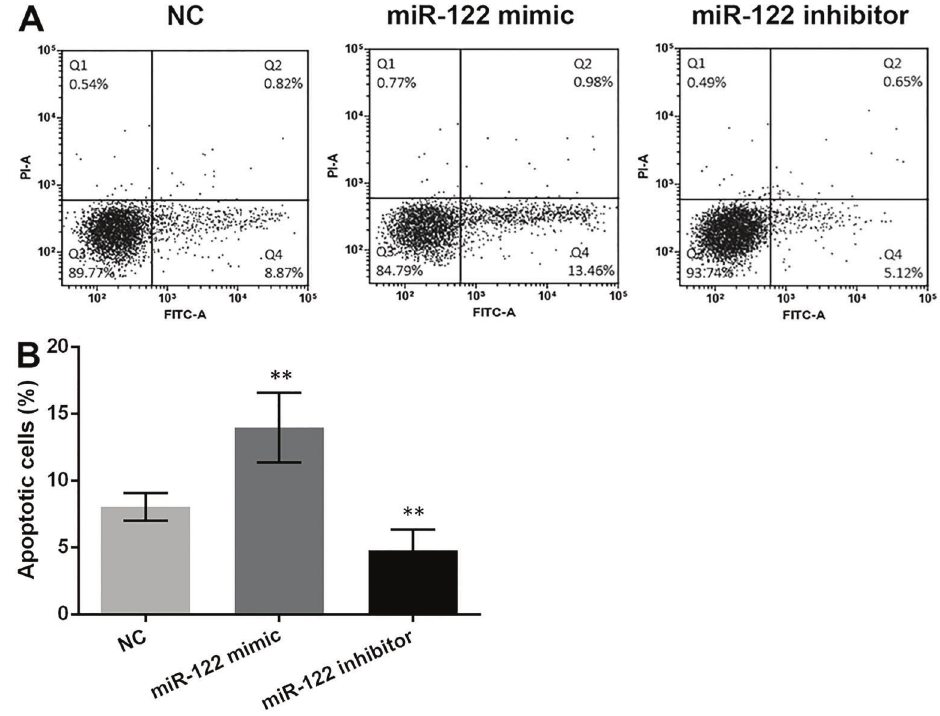
Figure 3. Apoptosis of transfected mouse cardiomyocytes. Mouse cardiomyocytes were transfected with miR-122 mimic, miR-122 inhibitor or the negative control (NC), and fl ow cytometry was performed at 48-h post-transfection. A , Flow cytometry results after the cells were treated with fl uorescein isothiocyanate (FITC) and propidium iodide (PI). The FITC-positive and PI-negative cells (in the lower right quadrant) were considered apoptotic cells. B , Percent of apoptotic cells according to the fl ow cytometry results. Data are reported as means ± SD. **P o 0.01 compared to NC group ( t